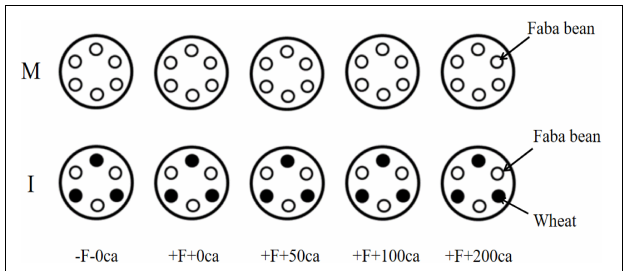
FIGURE 1 | Schematic diagram of hydroponic cultivation of nutrient solution in faba bean monocropping and wheat and faba bean intercropping. Ca, cinnamic acid; F, Fusarium oxysporum f. sp. fabae; I, intercropping; M,